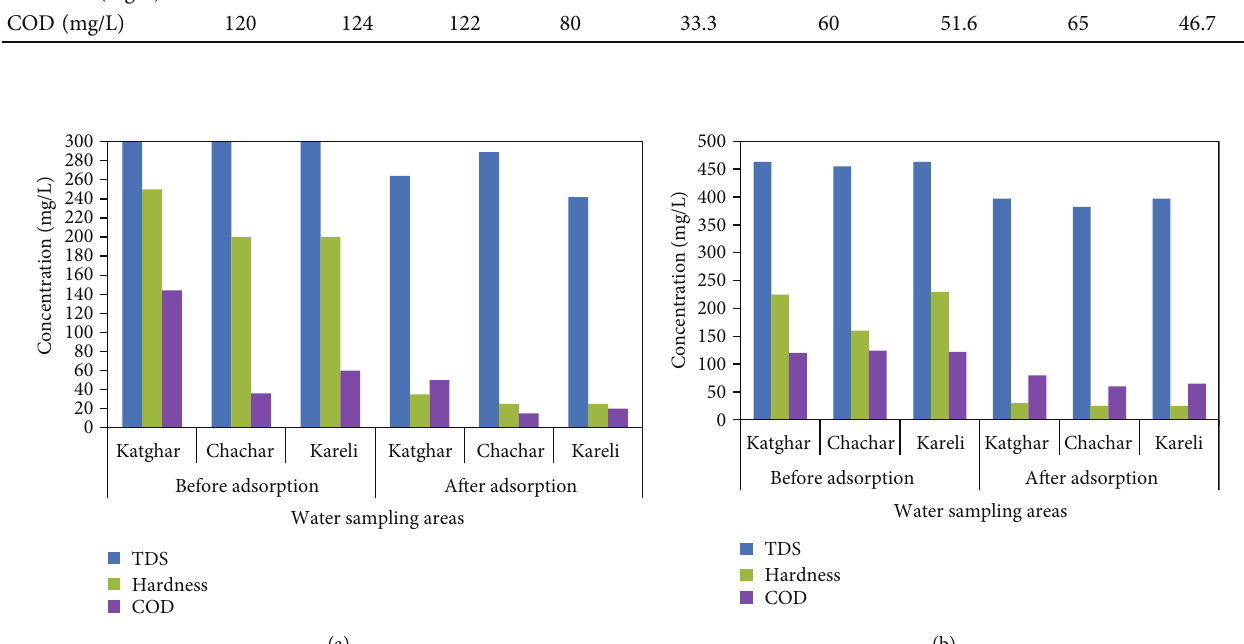
Figure 5: Graphical representation of the analysis conducted for various water quality parameters at di ff erent locations collected at (a) sampling area 1; (b) sampling area